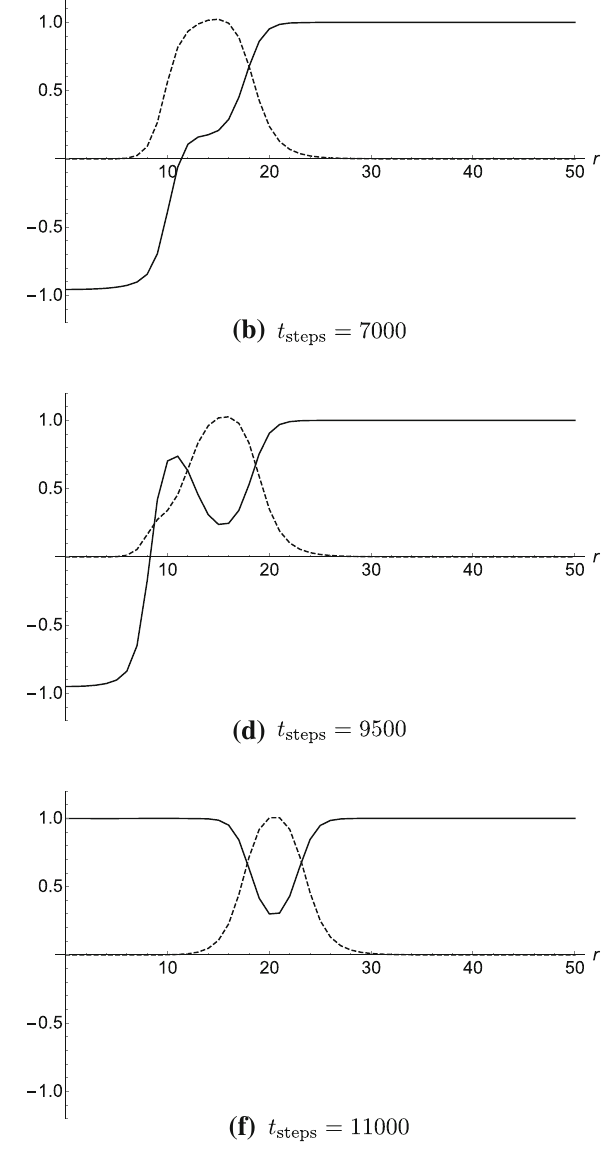
Fig. 6 X (solid)and Z (dashed)fieldconfigurationsat z = 0 atvarious numbers of steps in the iteration procedure. The procedure is relaxed for Q = 7000, and then set to Q = 6000, which is below the threshold